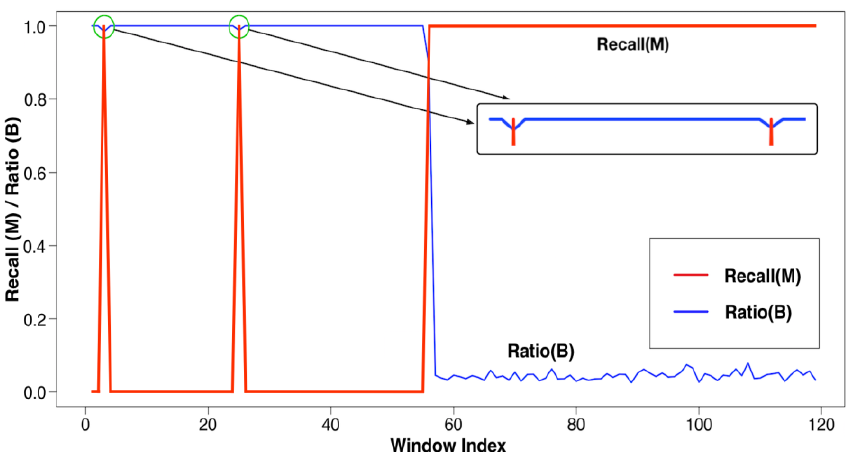
Figure 13. Correlation between recall toward malicious samples and ratio of benign samples.